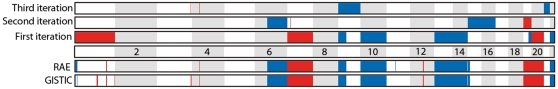
Comparison of the gains and losses found by iterative partitioning versus previous analyses.The horizontal tracks show the CNAs identified by first three iterations of our method, compared to the ones found by GISTIC and RAE. The middle track depicts the chromosomes, with even chromosome numbers annotated. Gains are denoted in red and losses in blue.